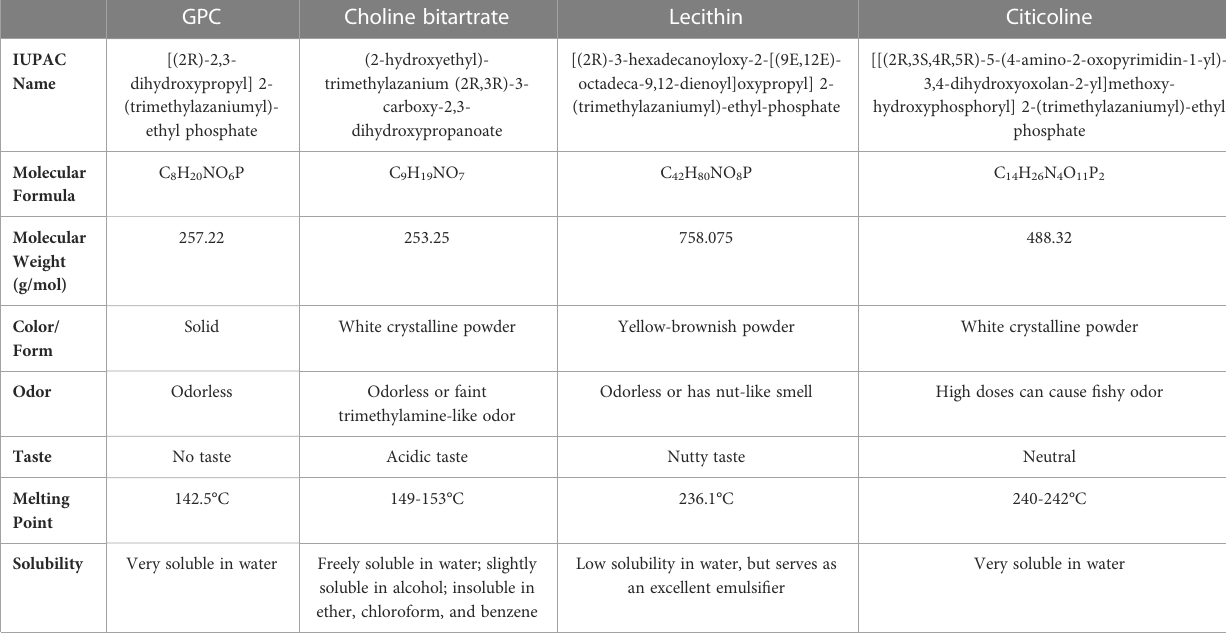
TABLE 2 Characteristics of the main different forms of choline